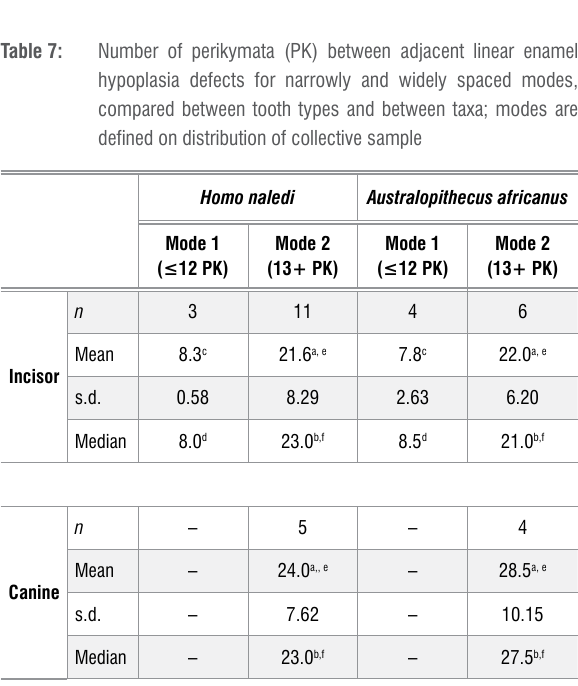
Table 7: Number of perikymata (PK) between adjacent linear enamel hypoplasia defects for narrowly and widely spaced modes, compared between tooth types and between taxa; modes are